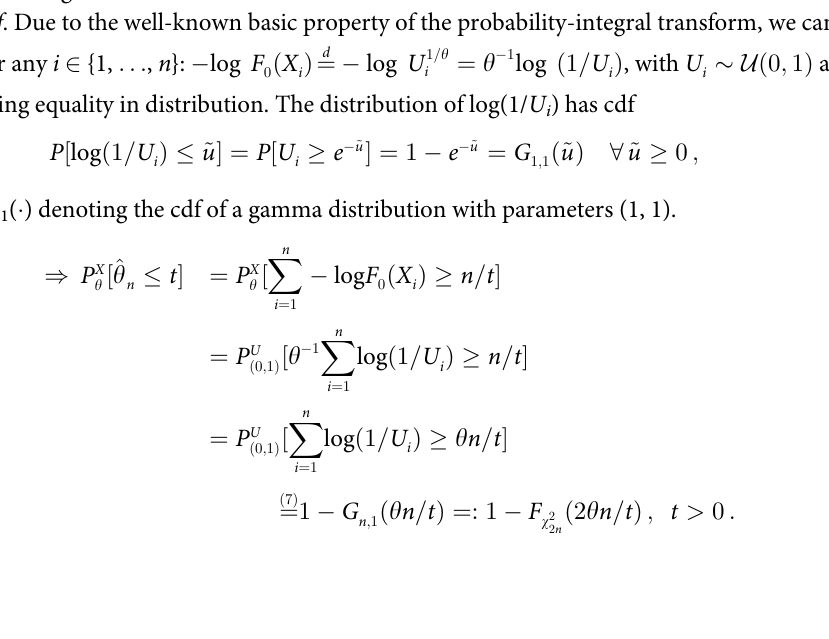
PLOS ONE | https://doi.org/10.1371/journal.pone.0256499 September 10,